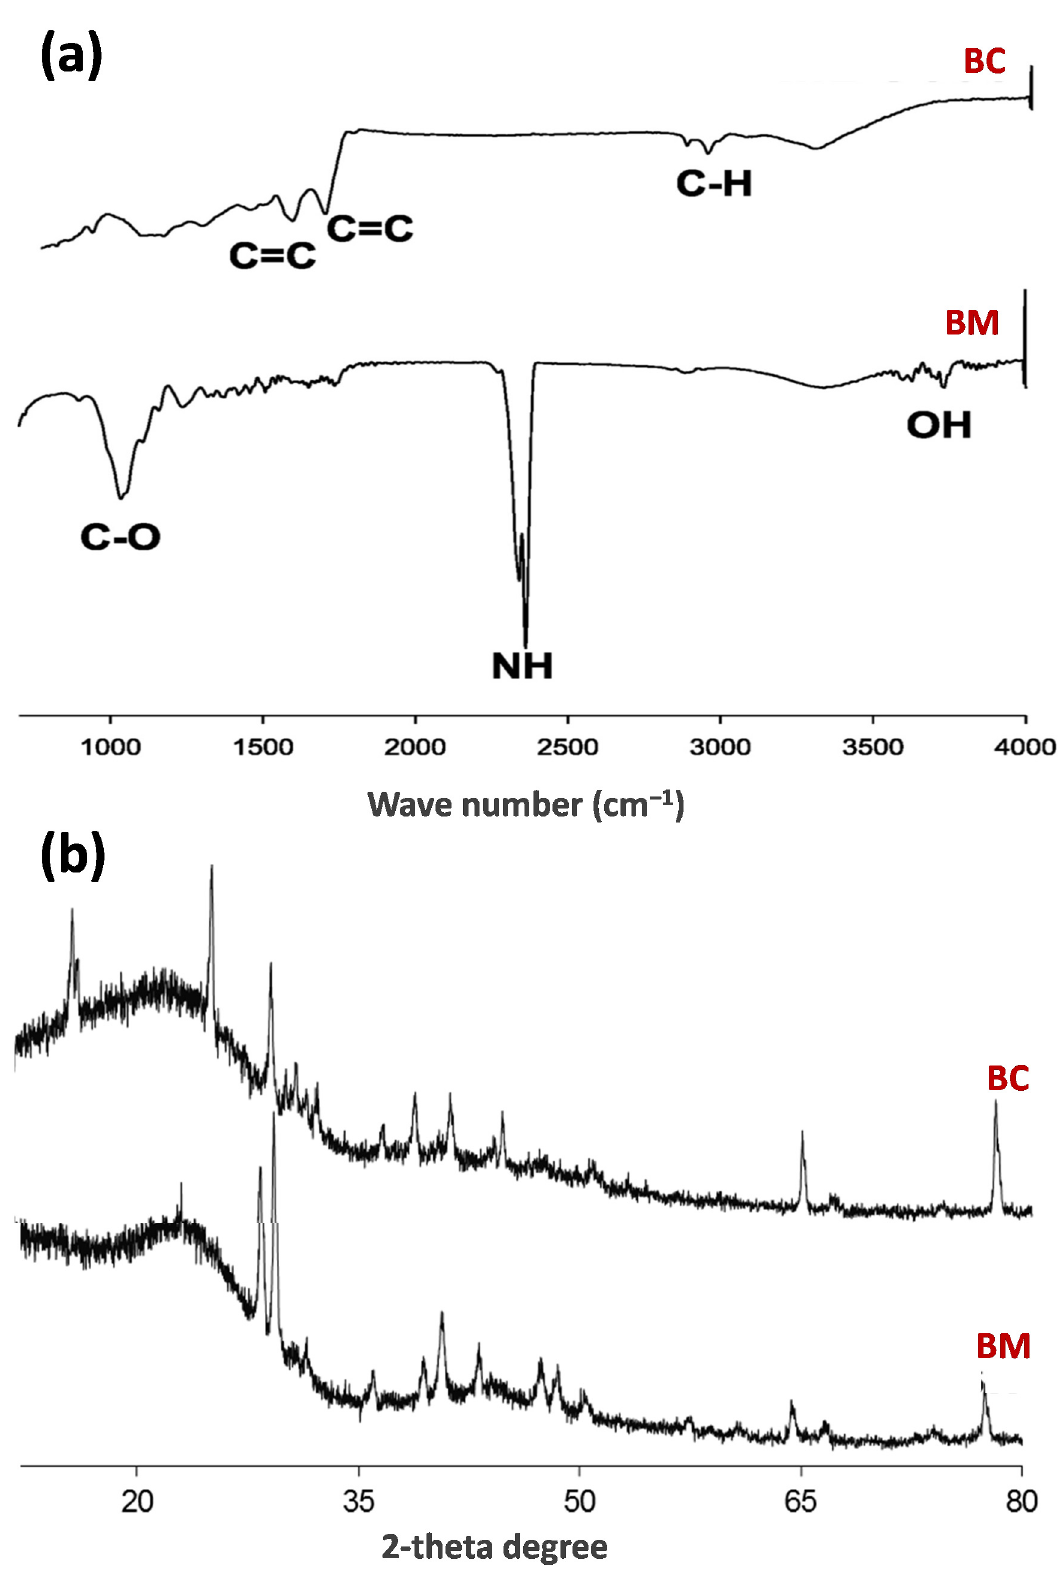
Figure 2. Fourier-transform infrared spectroscopy patterns ( a ) and X-ray diffraction analyses ( b ) of mesquite wood (BM) and BM-derived biochar